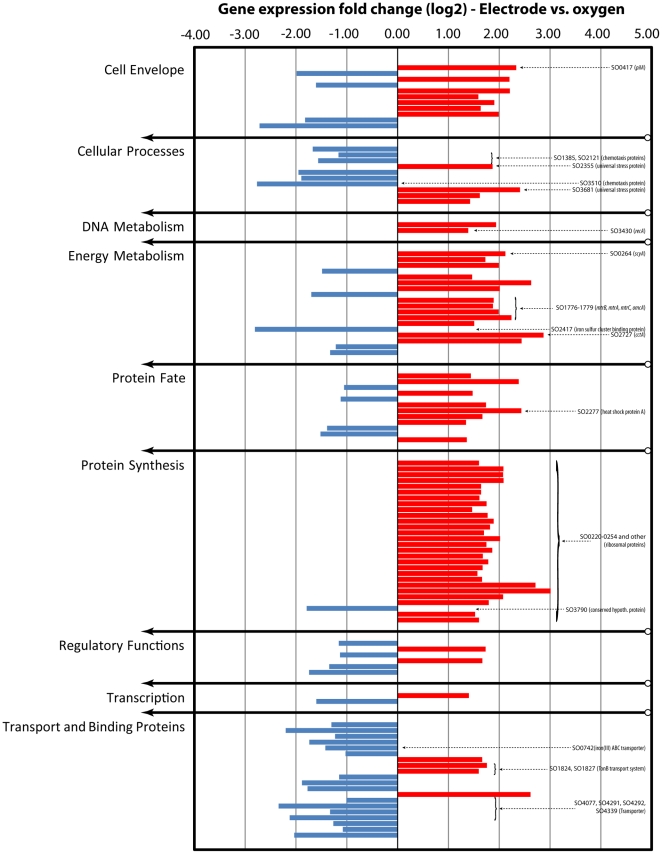
Differential expression levels of selected genes in comparision 2 (El vs. O2).Bar diagram showing the over and under expression of selected genes with the electrode in Comparison 2 (electrode vs. oxygen). The selection includes transcripts of interest with q≤0.2 and |logFC|<1, which have been designated by * in Table S2. Genes are clustered into functional groups. Most genes discussed in the text have been labelled.